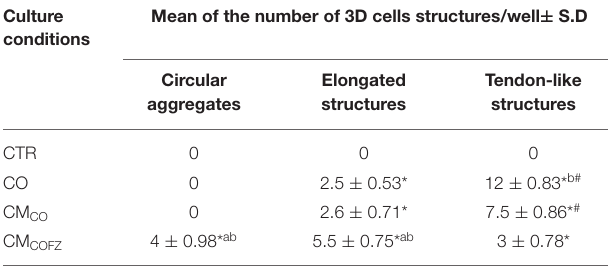
TABLE 4 | CM COFZ has a reduced teno-inductive capacity. Culture Mean of the number of 3D cells structures/well ± S.D conditions Circular Elongated aggregates structures